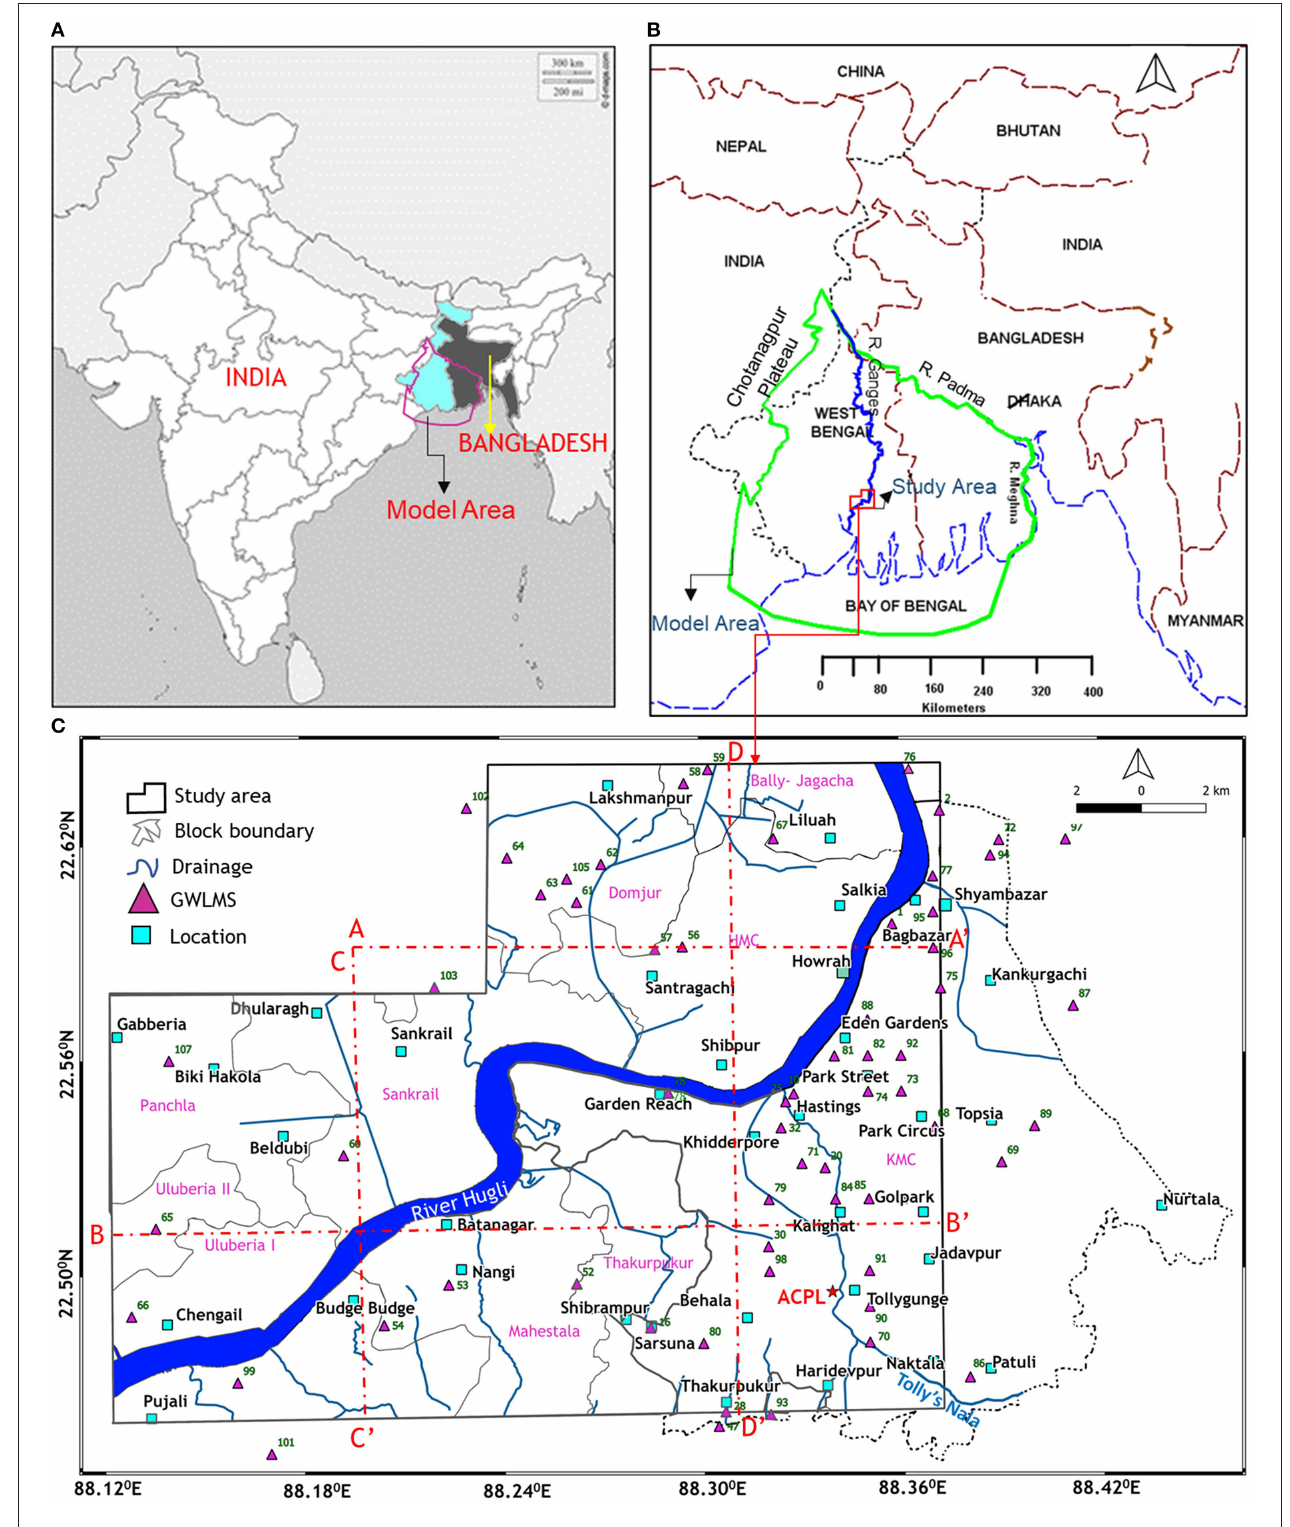
FIGURE 1 | (A) Location of the model area in the map of West Bengal (India) and Bangladesh. (B) Location of the model boundary where the green line indicates the model boundary, the red boundary indicates the study area, the dotted blue line indicates the coastline, the brown line indicates the international boundary, and the black dashed line indicates the state boundary. (C) Location map of the study area showing block boundaries, drainage, groundwater-level monitoring stations (GWLMS) and section lines (AA ′ , BB ′ , CC ′ , DD ′ ) for Figure 2 .